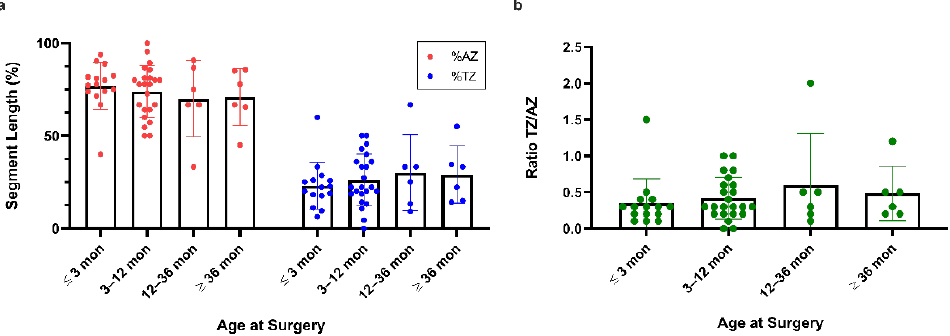
Figure 4. ( a ) Segment length of AZ and TZ in relation to the total length of the resected section sorted by age at surgery. The AZ section represents the major part of the resected bowel in most patients with a mean AZ = 73.97% and a mean TZ = 26.03%. ( b ) TZ/AZ ratio of all patient specimens sorted by age at surgery, showing that the TZ length is less than half the length of AZ in most patients (AZ/TZ ≤ 0.5 in n = 39 patients) and with a tendency towards a longer TZ in older patients.